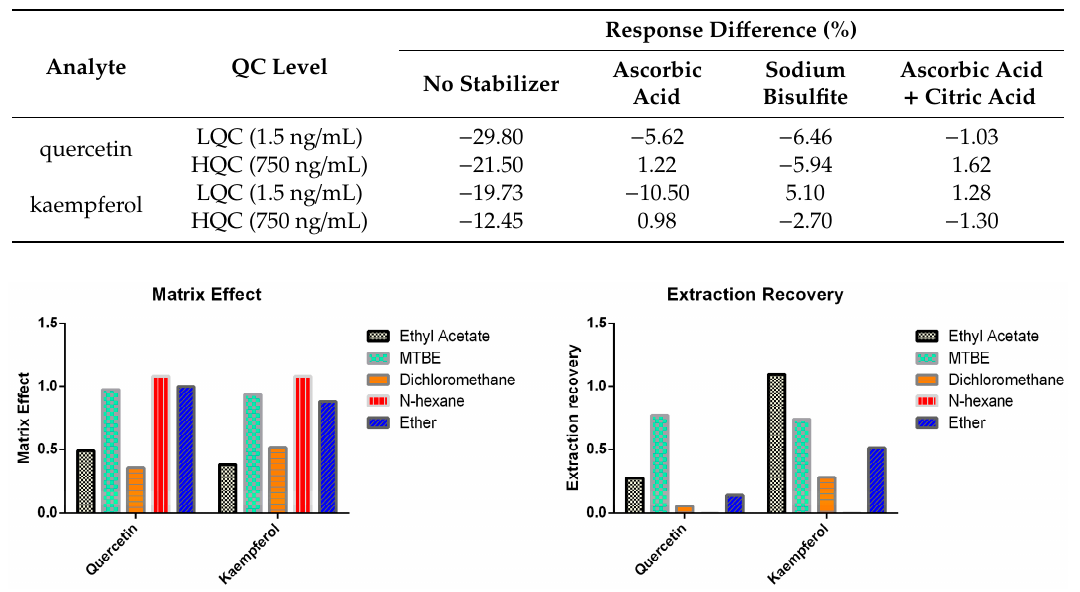
Figure 2. Comparison of matrix effect and extraction recovery of different extractants based liquid-liquid extraction method. Methyl tert -butyl ether, MBTE.